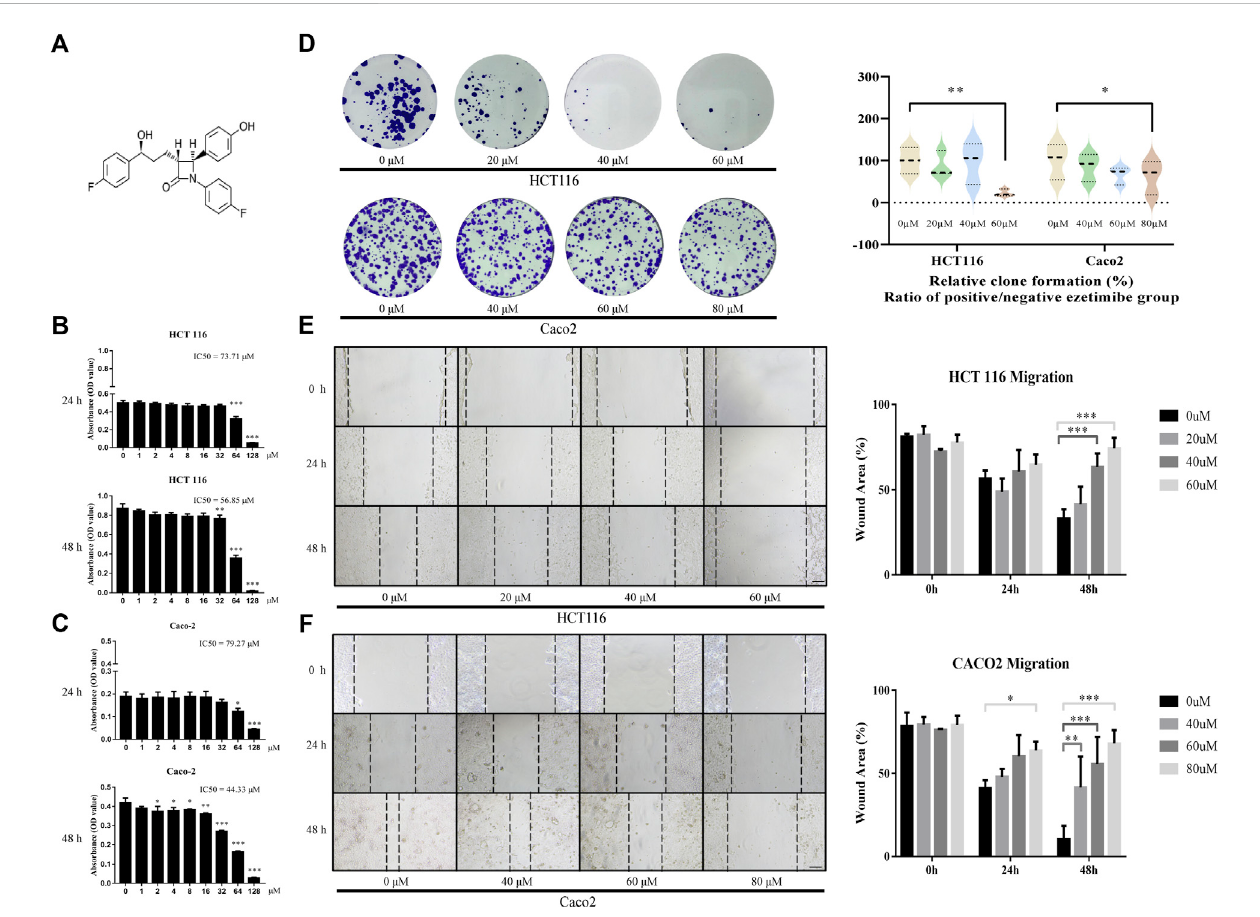
FIGURE 1 Ezetimibe suppresses the CRC cell activity by decreasing its proliferation and restraining its migration. (A) Chemical structure of ezetimibe. (B) Effects of ezetimibe on the viability of HCT116 at 24 and 48 h detected by CCK-8 assay. (C) Effects of ezetimibe on the viability of Caco2 at 24 and 48 h detected by CCK-8assay. (D) ThevariationsofcloneformationforHCT116andCaco2cellsundergradientezetimibetreatmentat48 h. (E) Thewoundhealingcapacityfor HCT116 under gradient ezetimibe treatment at 0, 24 and 48 h. Scale bar, 100 μ M. (F) The wound healing capacity for Caco2 under gradient